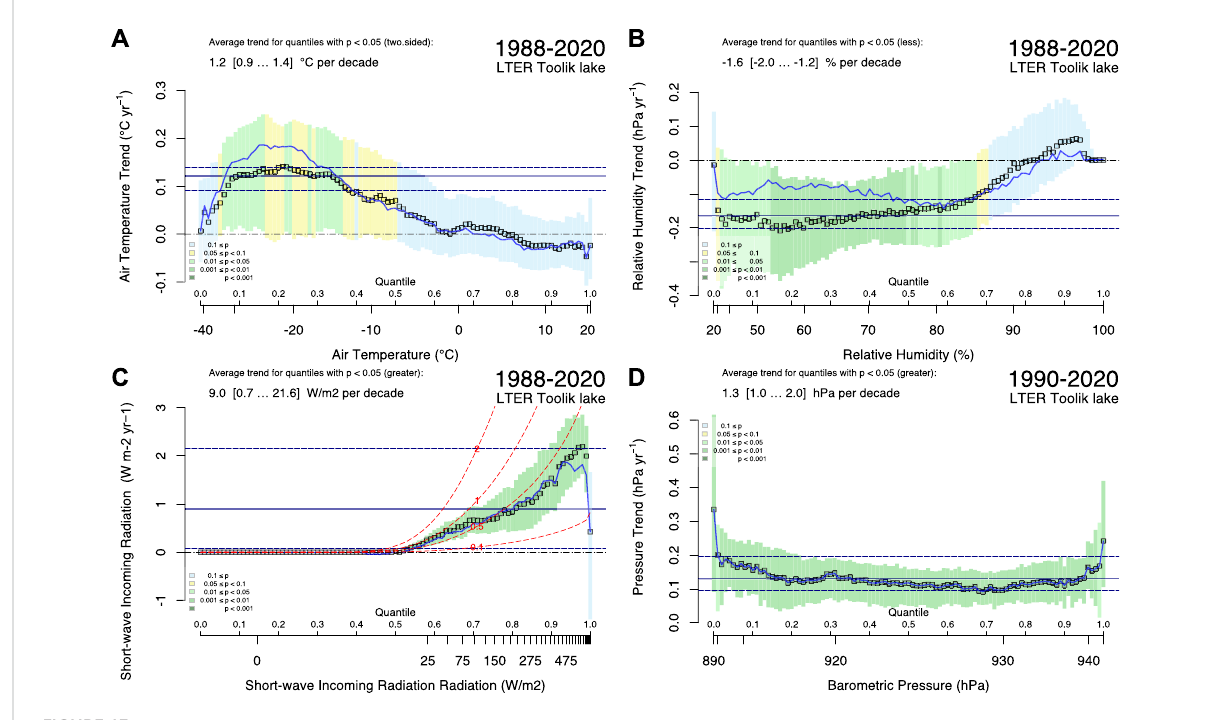
FIGURE 13 Quantileregressiontrendestimatesof (A) airtemperatures(two-sidedtest), (B) decreasingrelativehumidityattemperaturesabovefreezing, (C) increasing global radiation, and (D) increasing barometric pressure. Display as in Figure